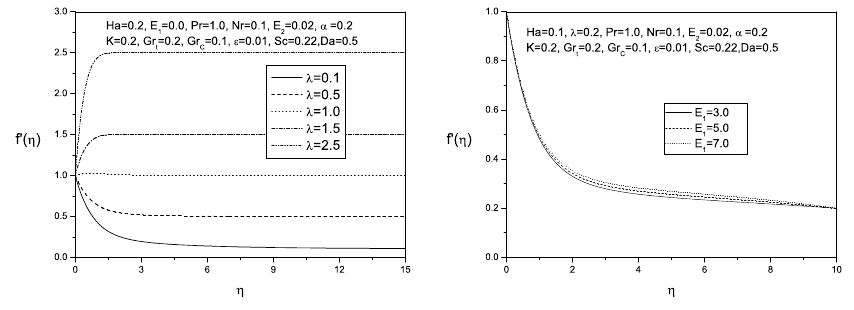
Figure 4. Variation of velocity profiles f (cid:48) with η for different values of λ .